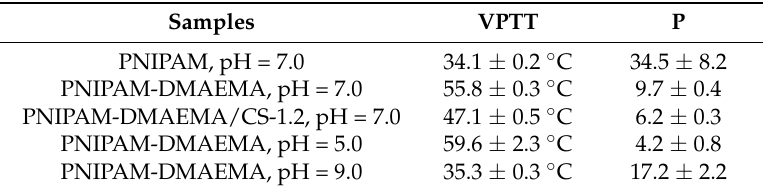
Table 2. VPTT and cooperativity (P) values found by fitting the turbidity courses of pure PNIPAM and PNIPAM-DMAEMA solutions (0.02 M) at pH = 7.0 and PNIPAM-DMAEMA/CS dispersions (0.01 M) at pH = 5.0, 7.0 and 9.0 versus temperature according to Equation (2). Samples VPTT P PNIPAM, pH = 7.0